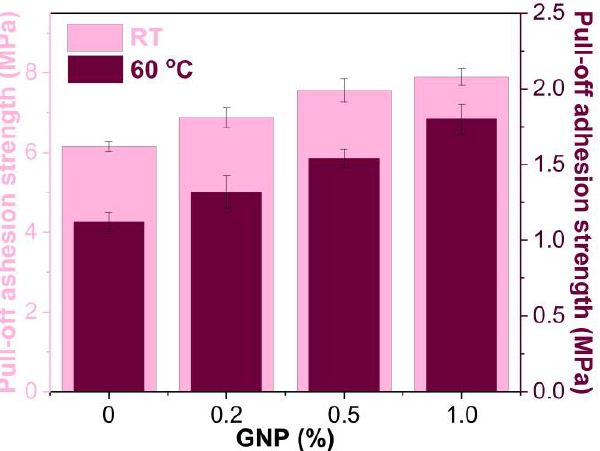
Figure 15. Area of adhesive failure on the steel plates bonded with GNP-reinforced EABCs after single-lap shear tests.